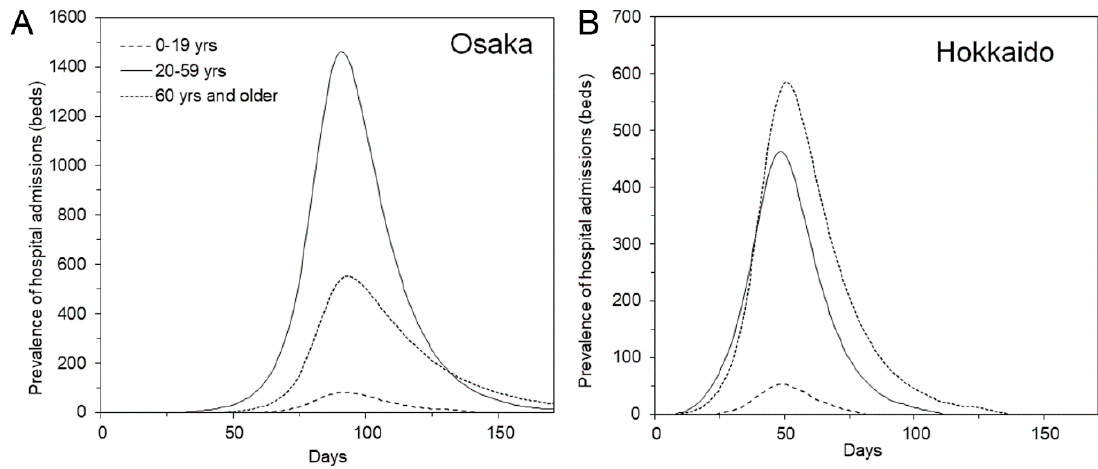
Figure 2. Reconstructed epidemic dynamics for working-age centered and elderly centered prefectures. ( A ) Working-age centered model, as parameterized by datasets in Osaka. The peak of hospital admissions of young adults was higher than that of older people. ( B ) Elderly centered model, as parameterized by Hokkaido data. The prevalence of hospital admissions of the elderly exceeded that of young adults. In both scenarios, we assumed that all confirmed cases were to be hospitalized for a fixed duration of 14 days.